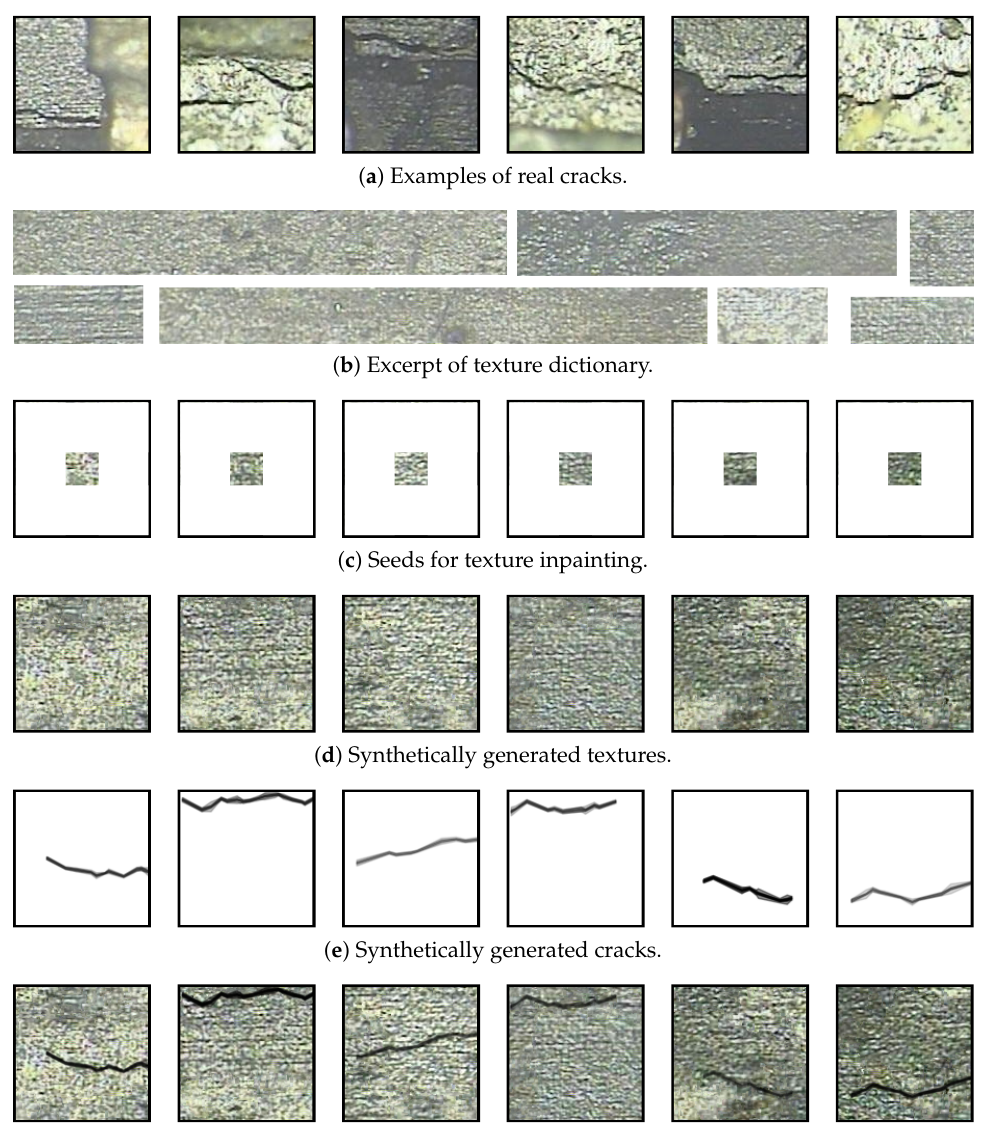
Figure 3. ( a – f ) Crack image